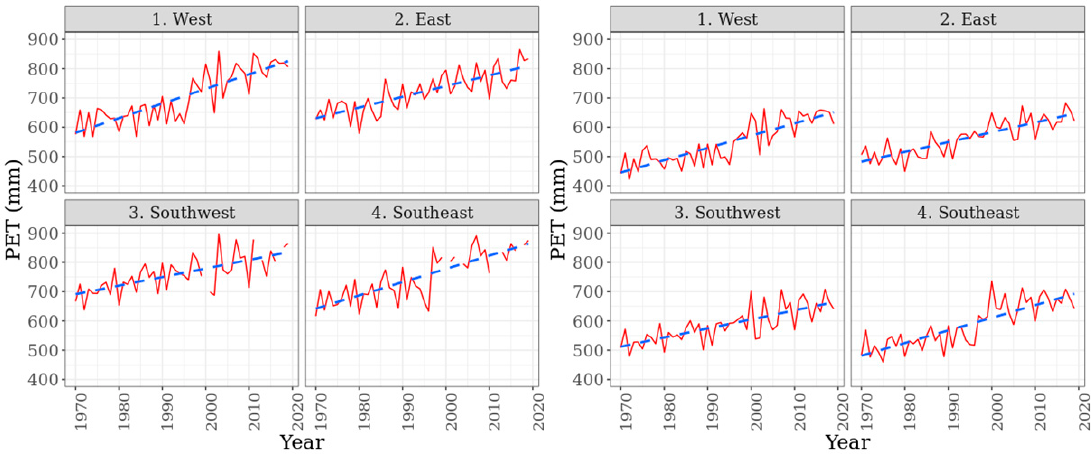
Figure 10. Annual ( left ) and seasonal * ( right ) values of PET in the four investigated regions (1970–2019). * Calculated for the vegetation period of maize (May–August).